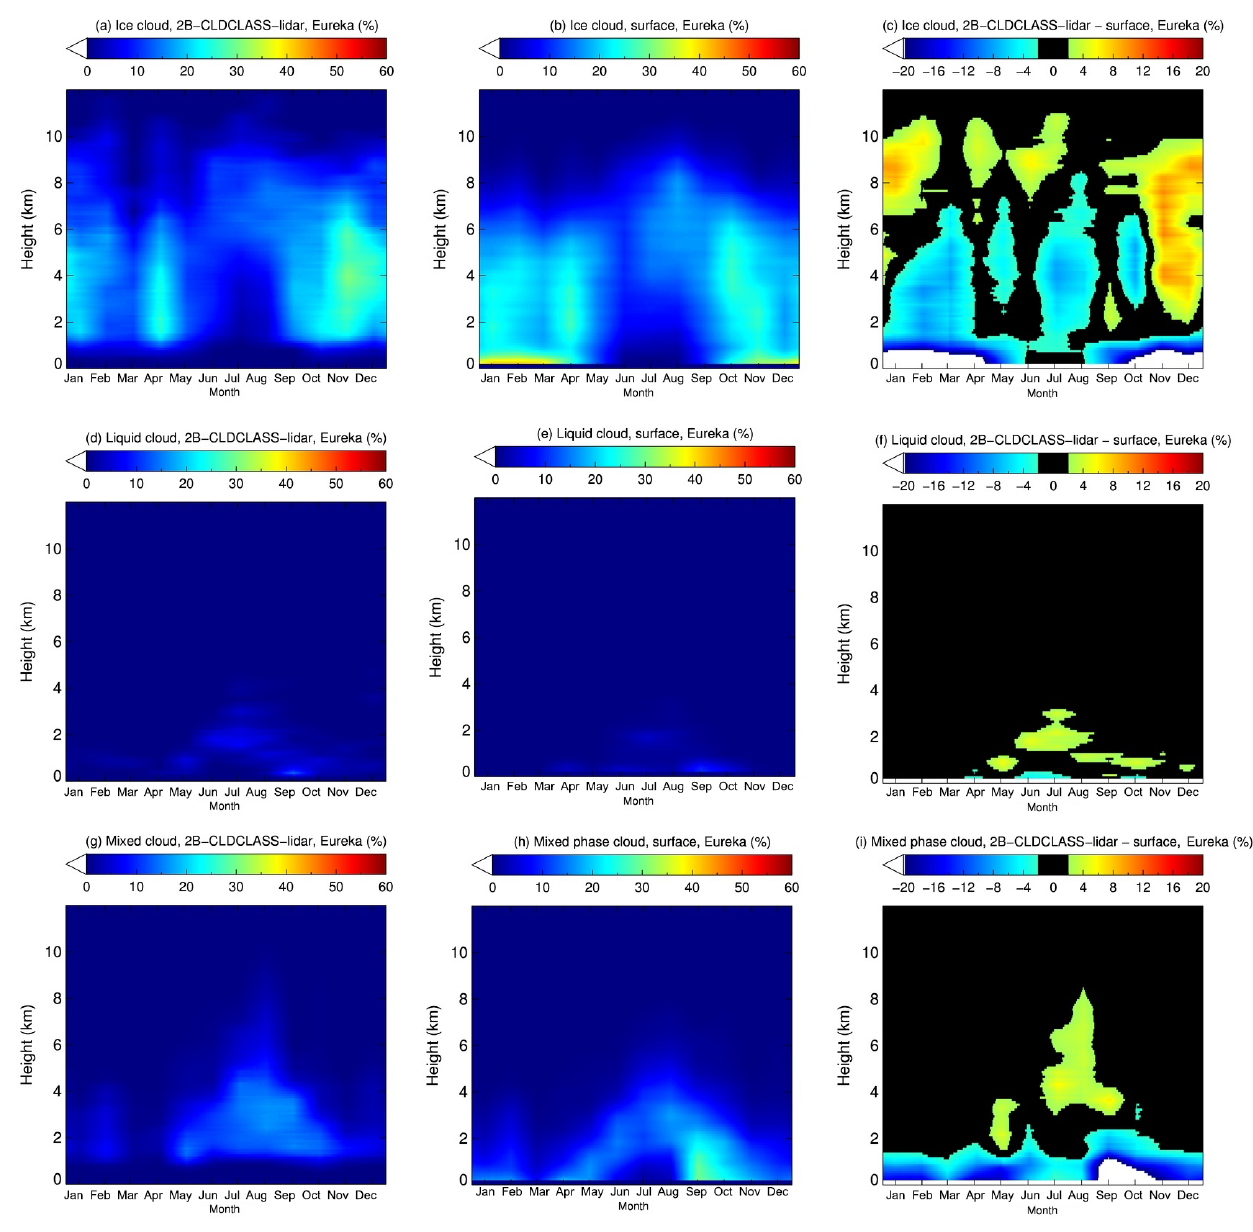
Figure 9. Vertical distributions of ice phase clouds (a–c) , liquid phase clouds (d–f) , and mixed-phase clouds (g–i) from 2B-CLDCLASS- lidar (a, d, g) , from surface observations (b, e, h) , and the difference of 2B-CLDCLASS-lidar and surface observations at Eureka for